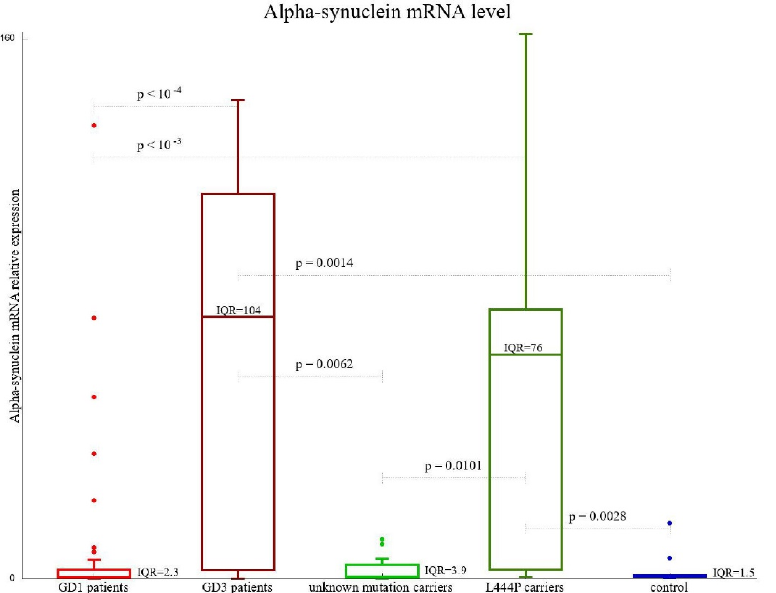
Figure 2. Alpha synuclein mRNA level. The SNCA gene expression level among GD1 and GD3 patients was compared to that among GBA1 mutation carriers and healthy control subjects. Results are presented as the change ‐ in ‐ cycling ‐ threshold using the Δ Cq method.